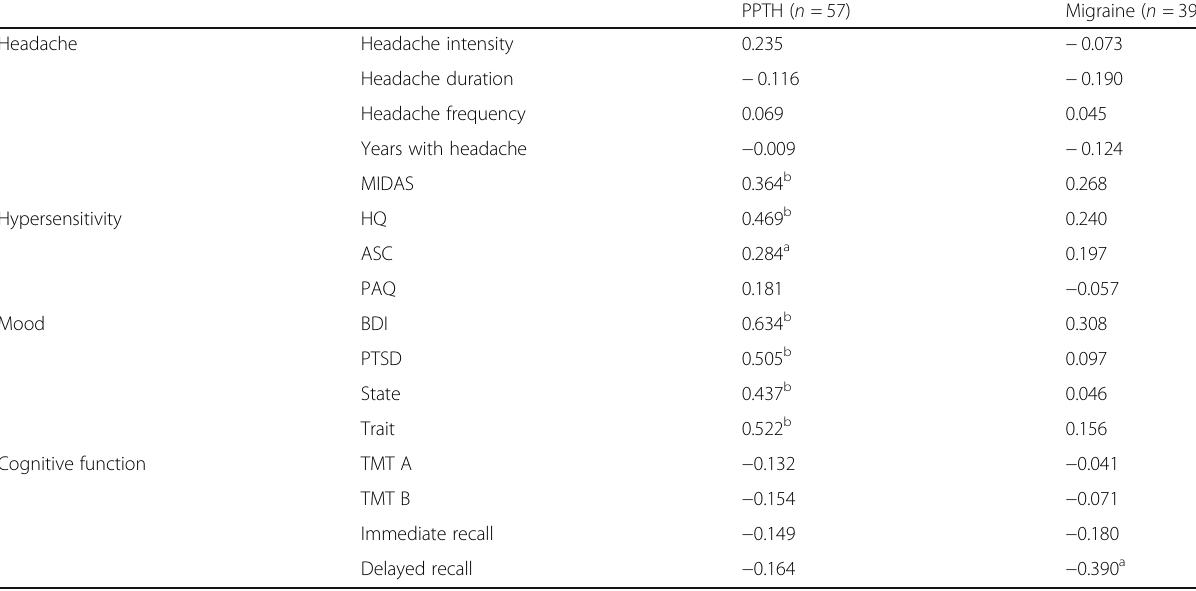
Table 3 Spearman correlation coefficients between Insomnia Severity Index and clinical